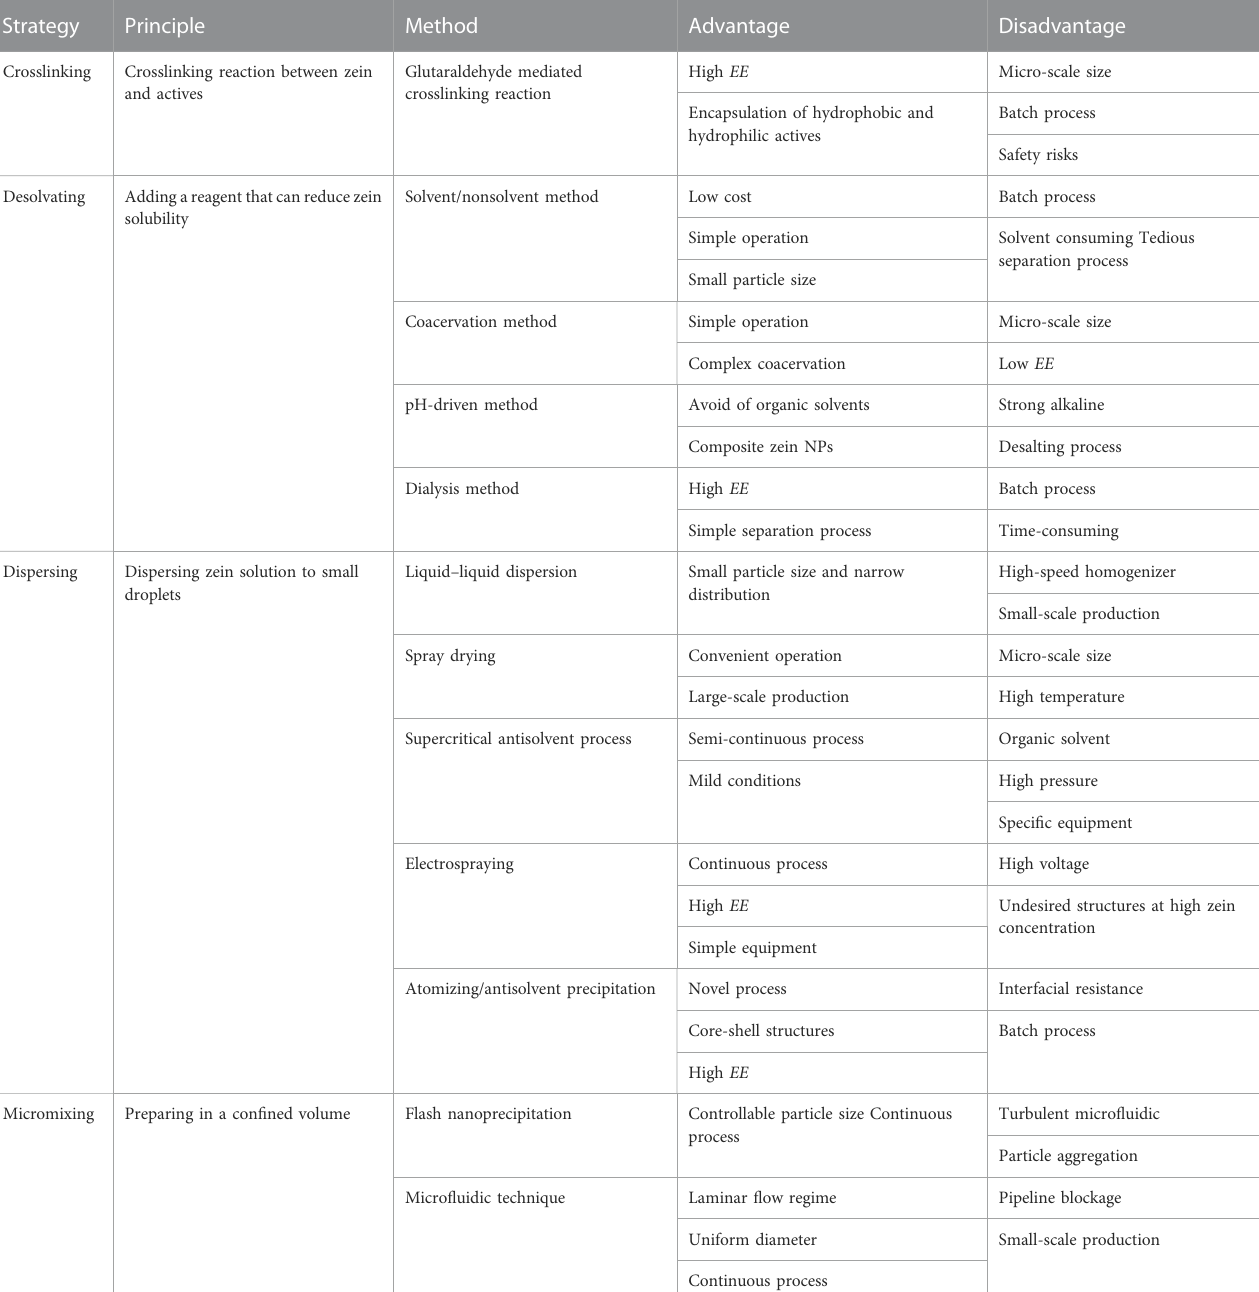
TABLE 1 Advantages and disadvantages of the strategies for zein NPs generation.